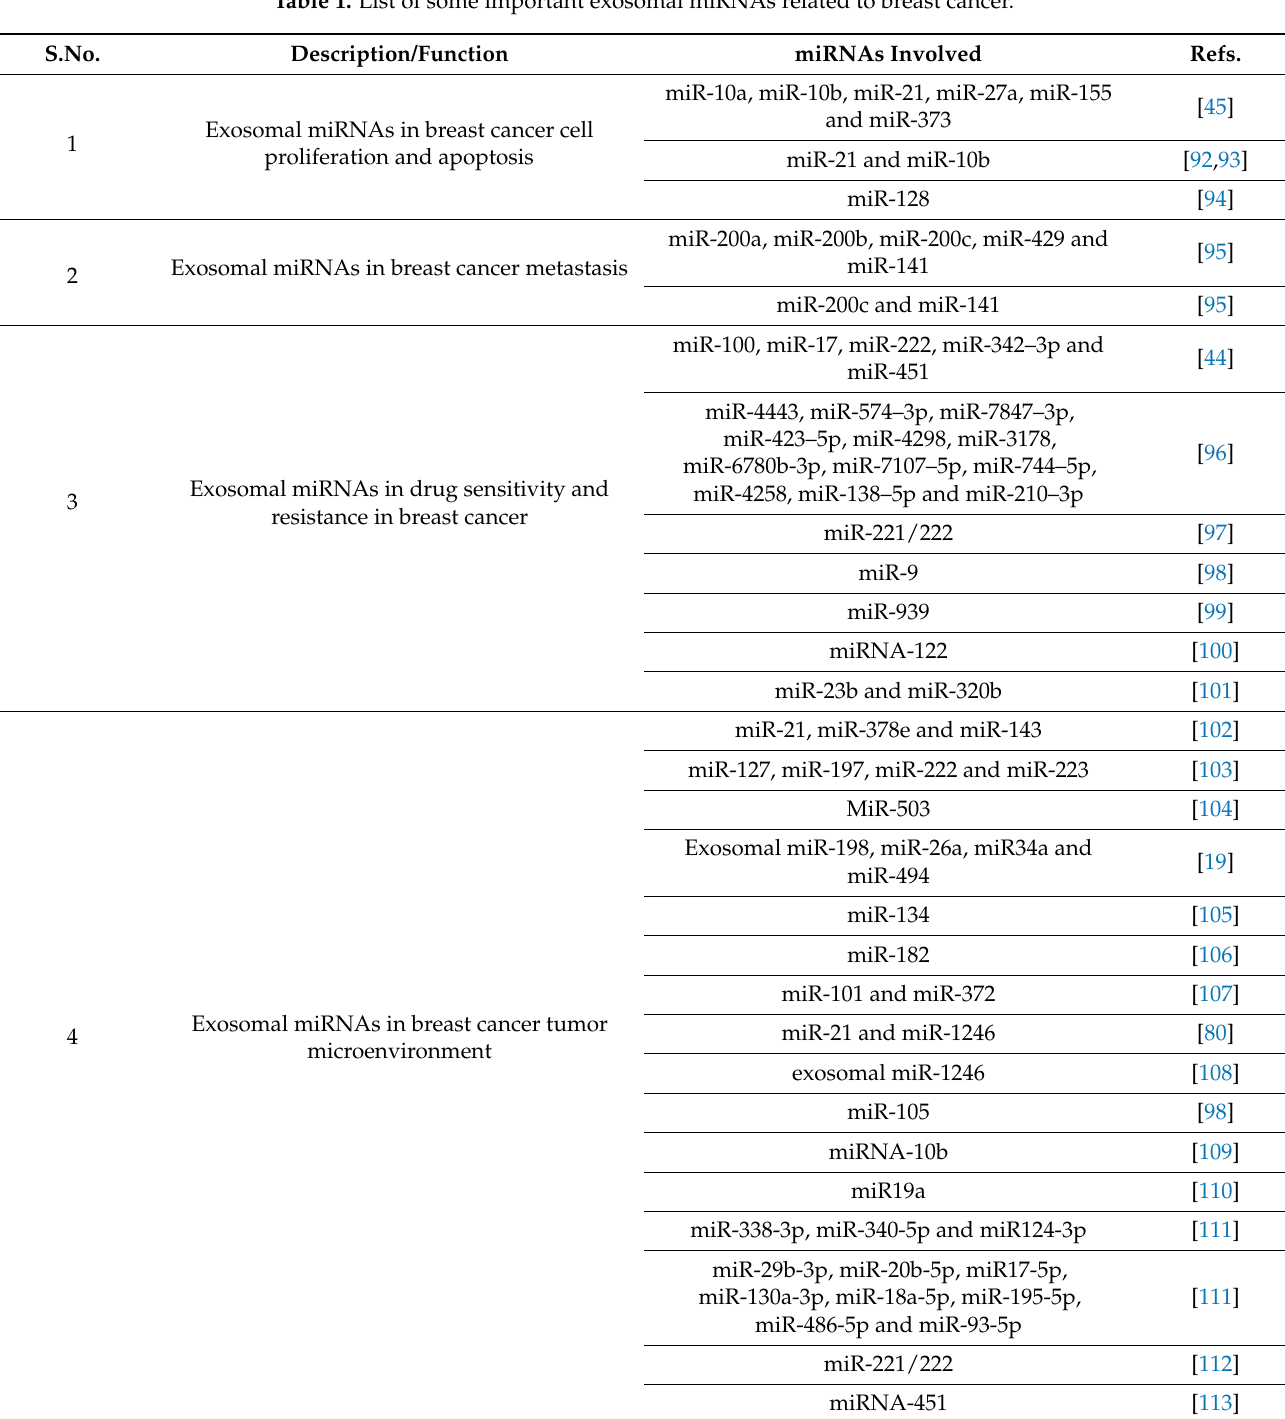
Table 1. List of some important exosomal miRNAs related to breast